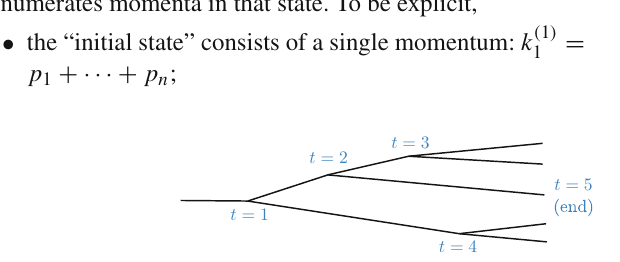
Fig. 2 With any fixed clustering algorithm, the probability distribution over final-state momenta can be decomposed into a product of distri- butions. Each factor in the product corresponds to a different step in